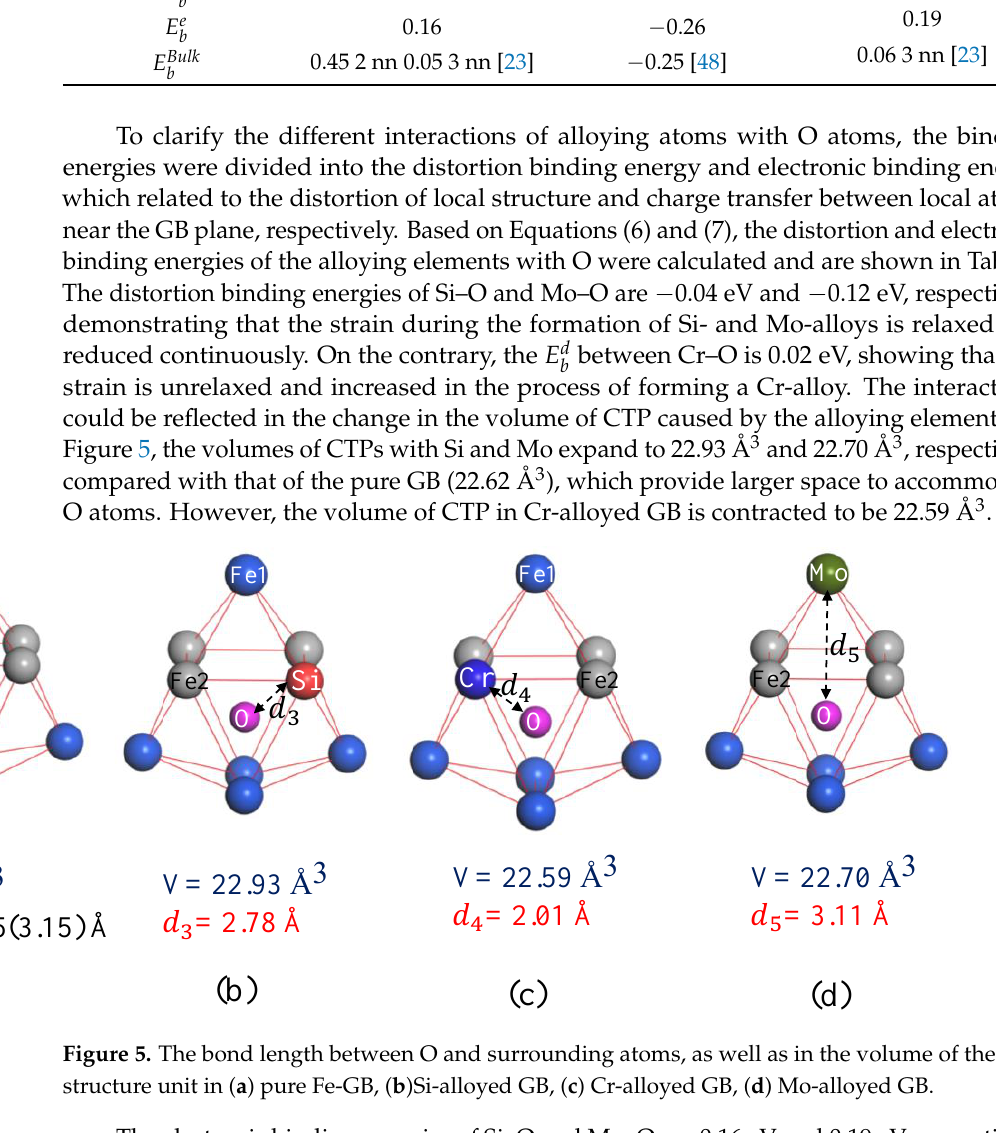
Table 2. Binding energies of alloying atoms with O at the GB and in bulk from the literature. E bind (eV) Si–O Cr–O Mo–O E bt 0.12 − 0.24 E bd − 0.04 0.02 − 0.12 E t b E be 0.16